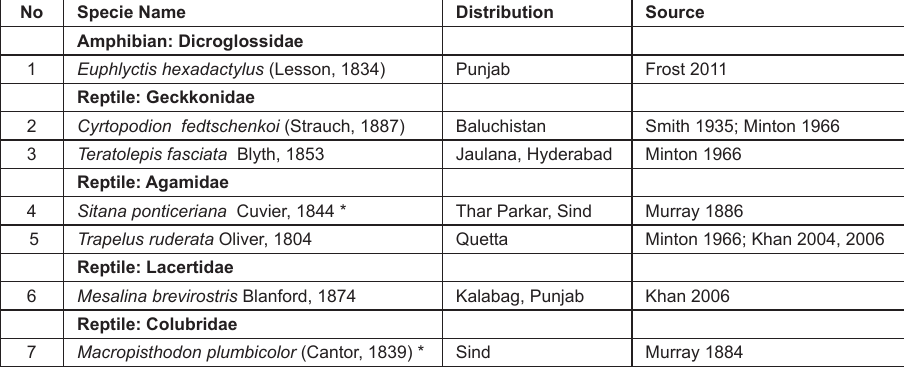
Table 1. List of species of amphibian and reptiles records from Pakistan in